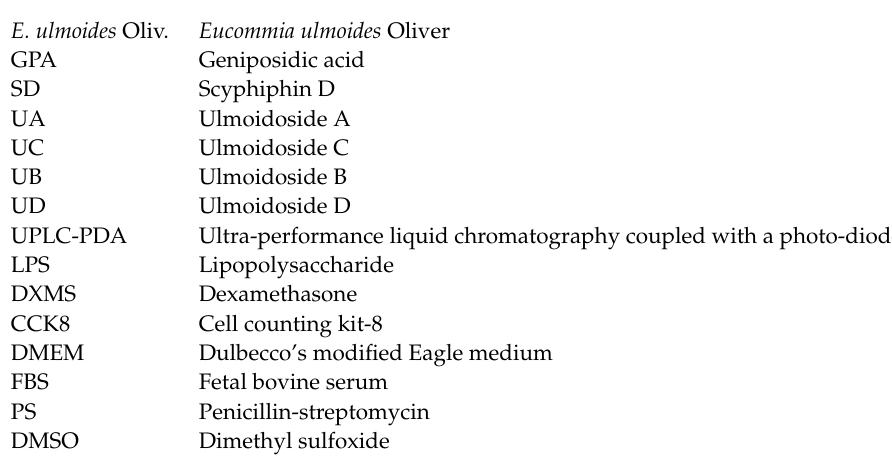
Figure S5: Representative UPLC chromatograms of UB in the exposed solution at different temperatures (A1) and pH levels (B1) for 24 h; Time–concentration curves of UB at different temperatures (A2) and pH 4~6 (B2); Time–concentration curves of UB and the degraded products at pH 2 (B3), pH 8 (B4), pH 10 (B5), and pH 12 (B6); The proposed degradation pathways of UB